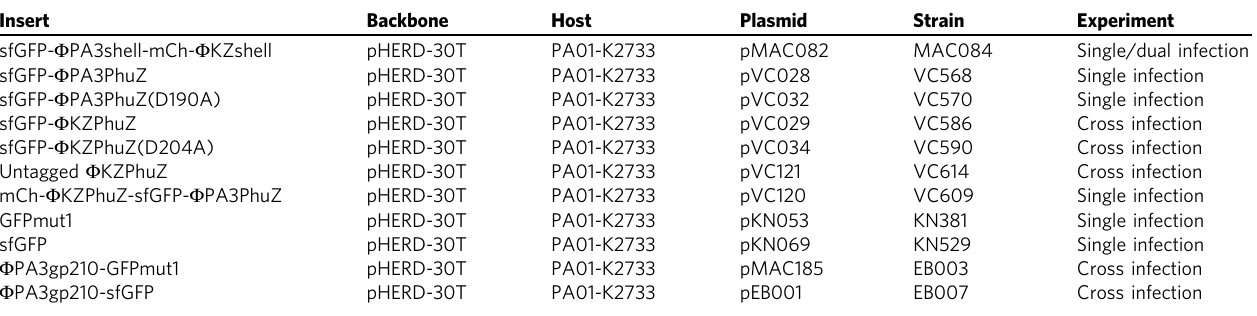
Table 2 Table of plasmids and strains used in this study.